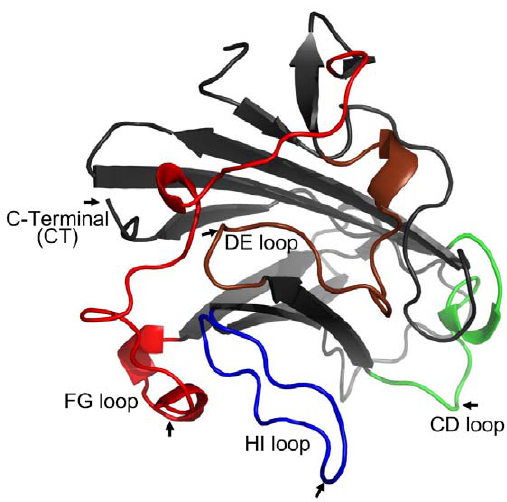
Figure 1. Epitope insertion sites in Ad5 fiber knob. The arrow indicates the location of P. aeruginosa OprF 14-mer epitope Epi8 inserted into loops CD (Green; Gly450/Thr451), DE (Brown; Asn464/ Gly465), FG (Red; Gly509/Lys510), HI (Blue; Gly543/Asp544 ) and C terminus (CT) of the Ad5 fiber protein (PDB 1KNB).